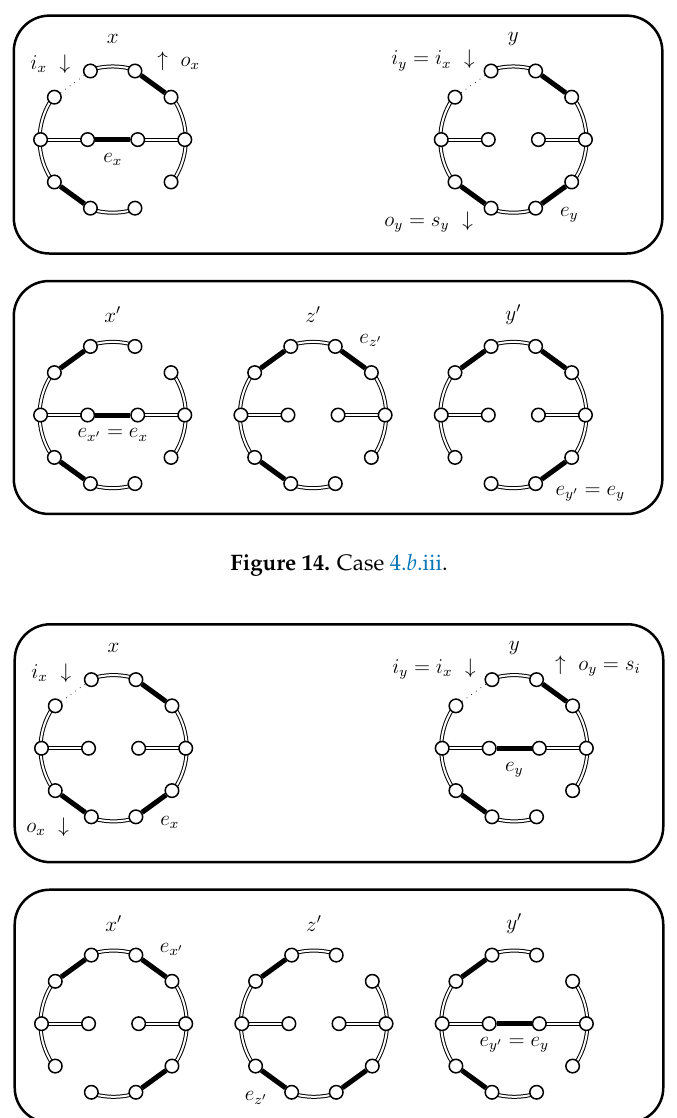
Figure 13: Case 4. b .ii.